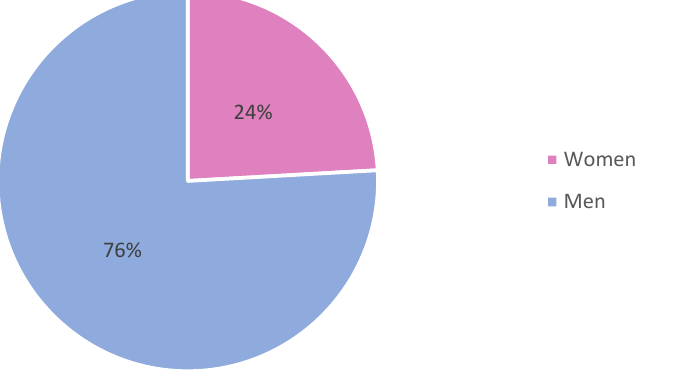
Figure 2. Structure of the respondents. The demographic structure of the respondents who participated in the survey is presented in Figure 3.